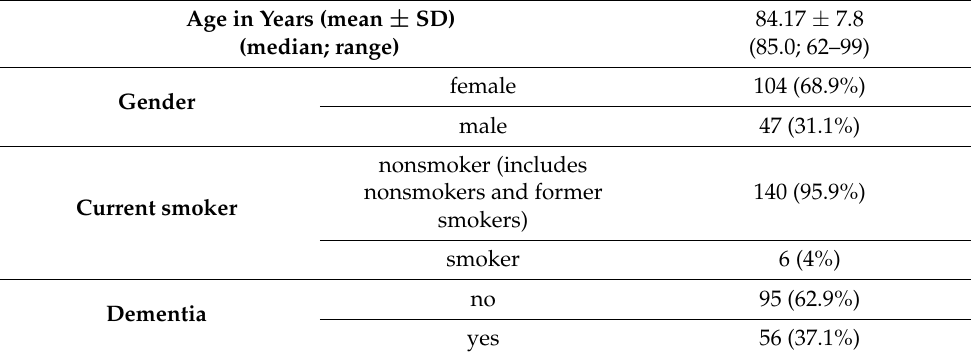
Table 1. Participants’ characteristics ( n =